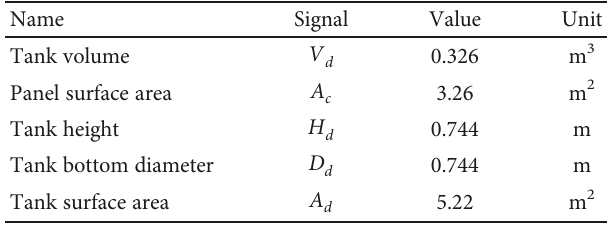
Table 3: Hot water tank dimension.